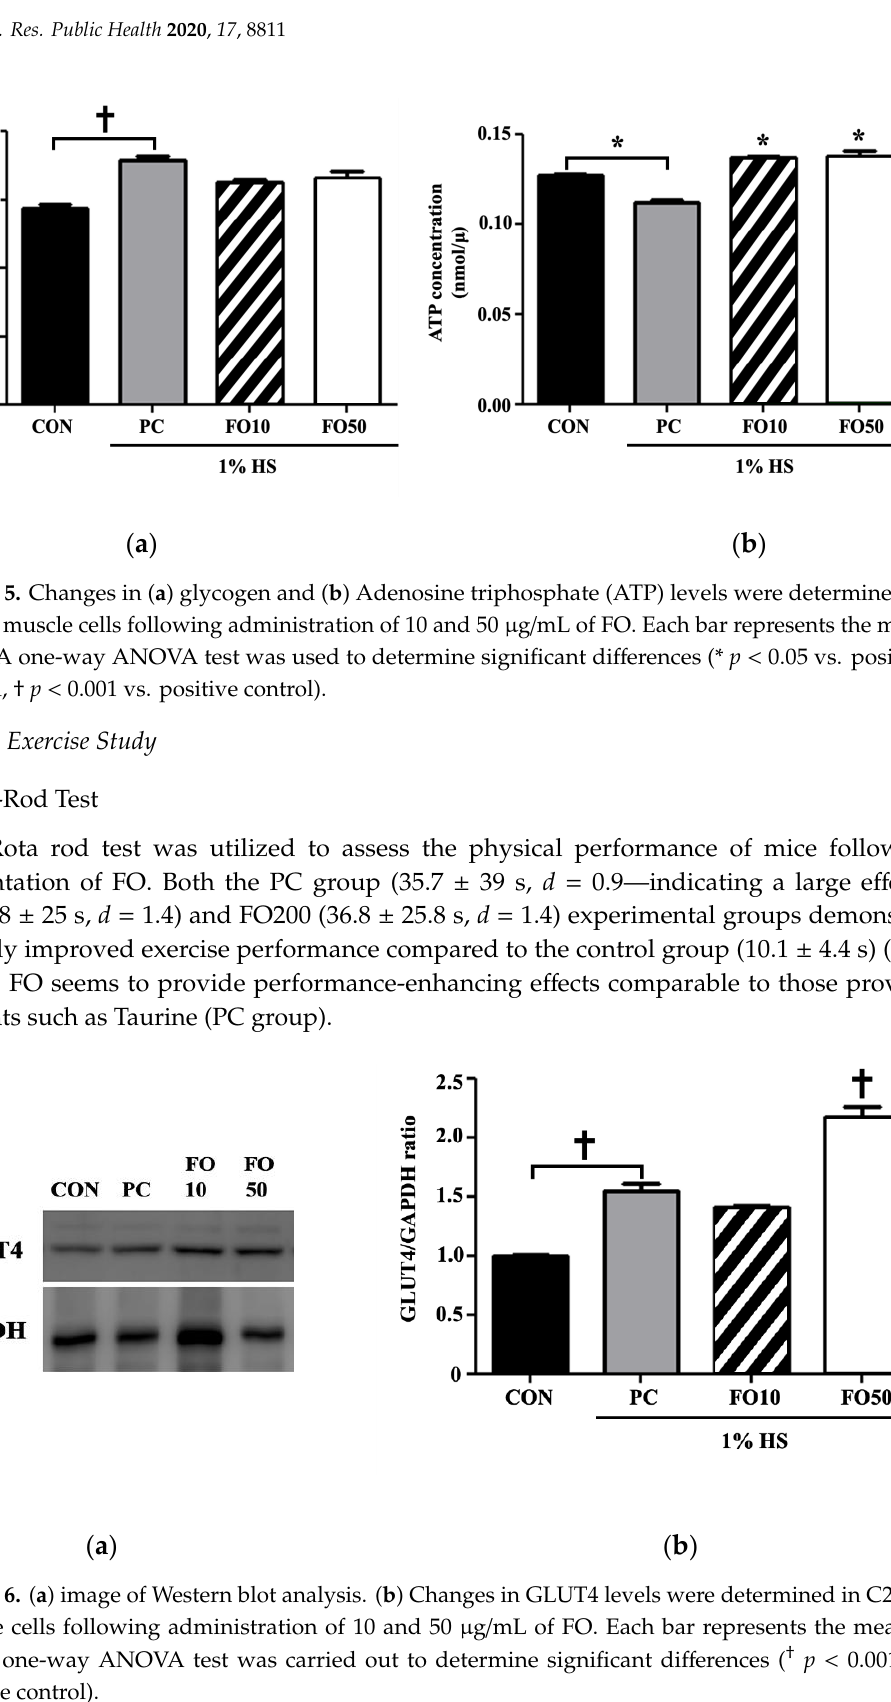
Figure 6. ( a ) image of Western blot analysis. ( b ) Changes in GLUT4 levels were determined in C2C12 Figure 6. ( a ) Representative image of Western blot analysis. ( b ) Changes in GLUT4 levels were muscle cells following administration of 10 and 50 µ g / mL of FO. Each bar represents the mean ± determined in C2C12 muscle cells following administration of 10 and 50 μg/mL of FO. Each bar SD. A one-way ANOVA test was carried out to determine significant di ff erences ( † p < 0.001 vs. represents the mean ± SD. A one-way ANOVA test was carried out to determine significant positive differences ( † p < 0.001 vs. positive control).